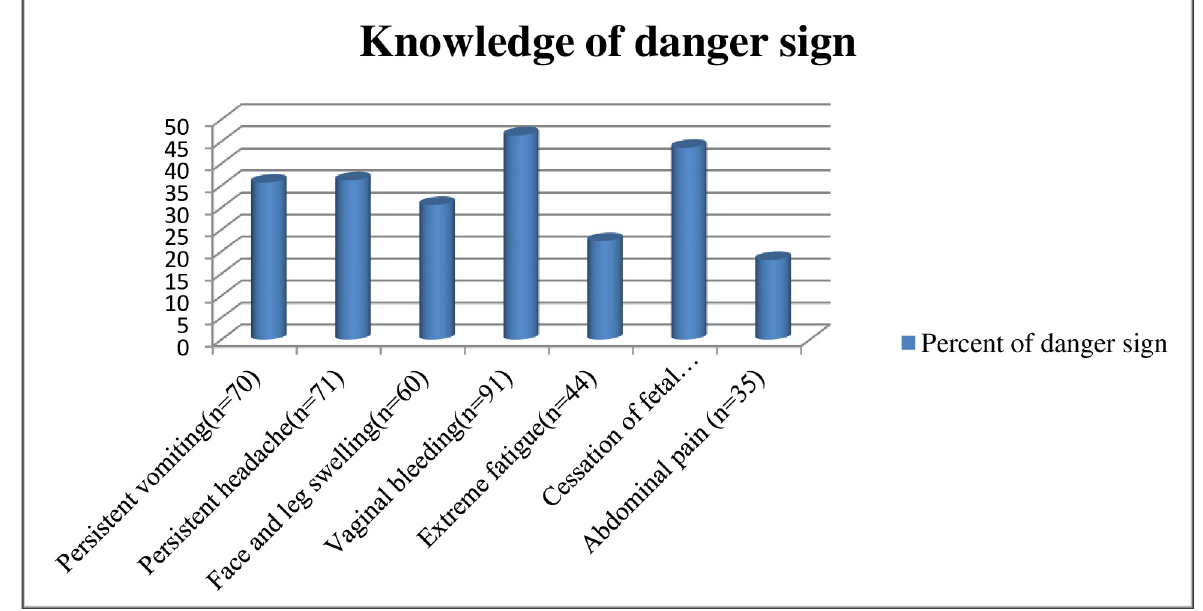
Fig 4. Knowledge about to danger sign in Mizan-Aman town, southwest, Ethiopia 2021.